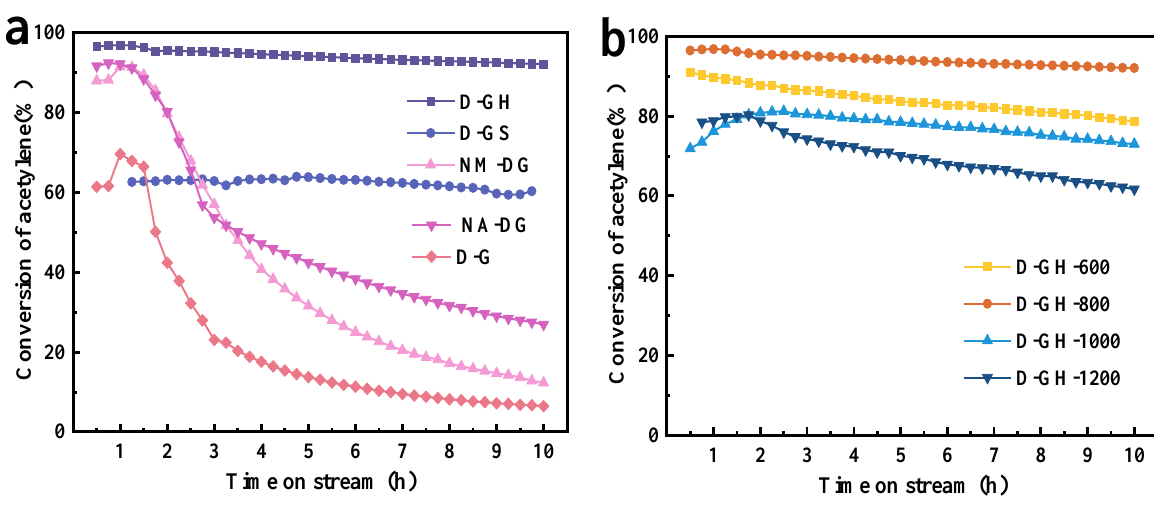
Figure 1. ( a ) The catalytic performance of carbon and nitrogen materials prepared from different biomass materials. ( b ) The catalytic performance of D-GH catalysts. Reaction conditions: T = 180 °C, C 2 H 2 = 36 h − 1 , velocity V HCl /V C2H2 = 1.15.